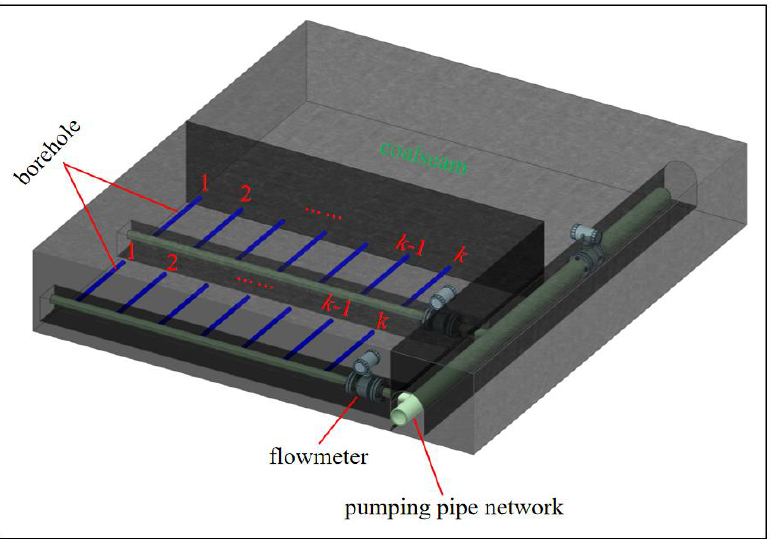
Figure 7. Schematic diagram of pumping pipe network.